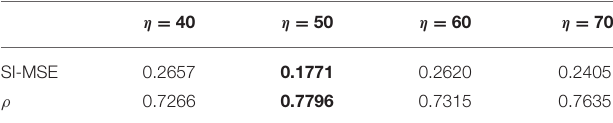
TABLE 6 | Results with different η